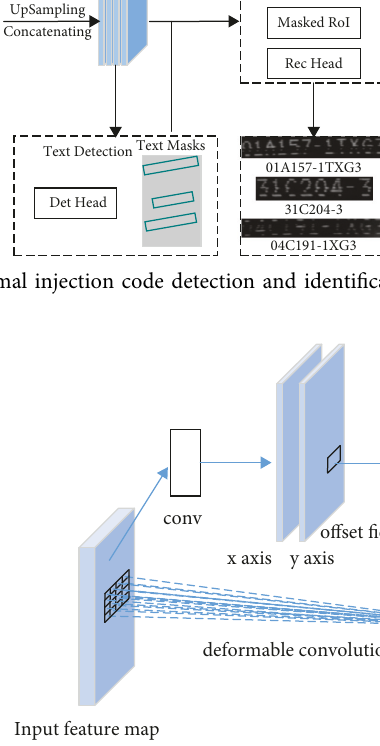
Figure 2: Deformable convolution.